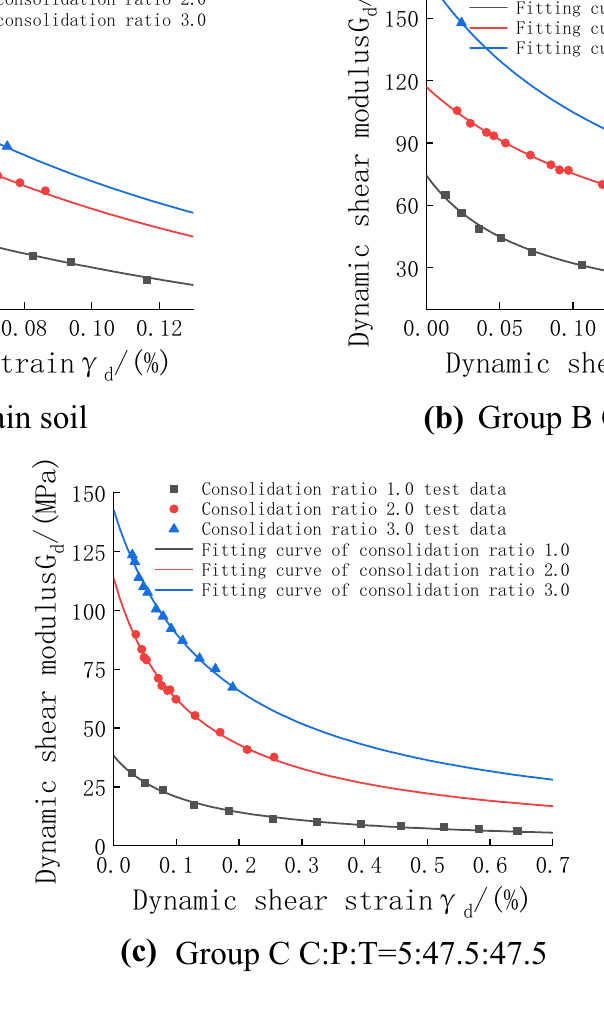
Fig. 10 Relationship between dynamic shear modulus and dynamic shear strain of phosphogypsum stabilized soil under different consoli- dation